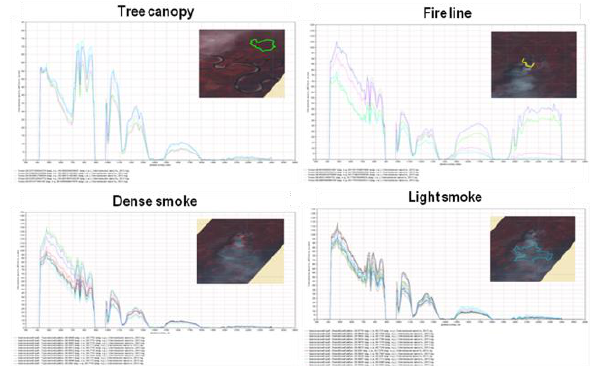
Figure 9. Hyperion (Sensors - Hyperion, 2011) spectral profile recovering.